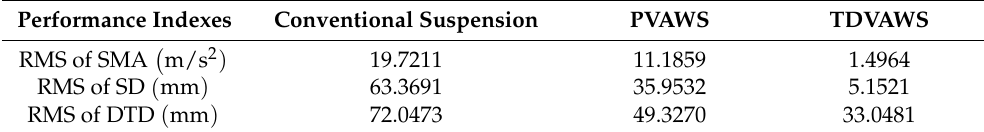
Table 5. RMS of vehicle performance indexes under harmonic excitation.